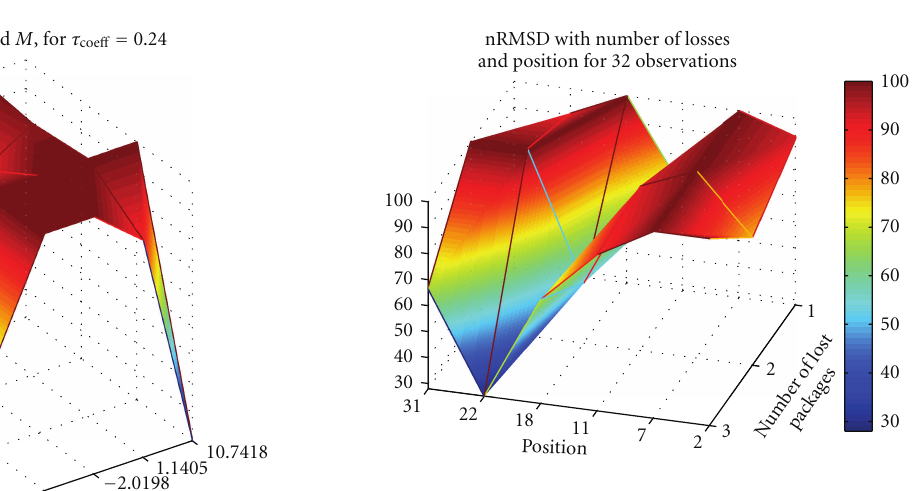
Figure 5: Dependence on number and position of lost packets, for Daubechies 4, M = 32, and τ coe ff = 0 . 14, of the nRMSD of a reconstructed BCG waveform.